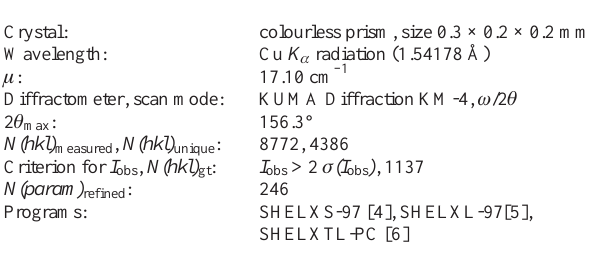
Table 1. Data collection and handling.